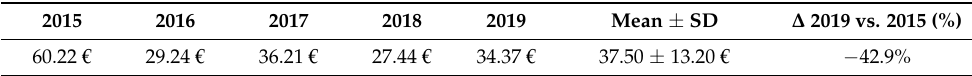
Table 4. Spending on antibiotics per case mix point.